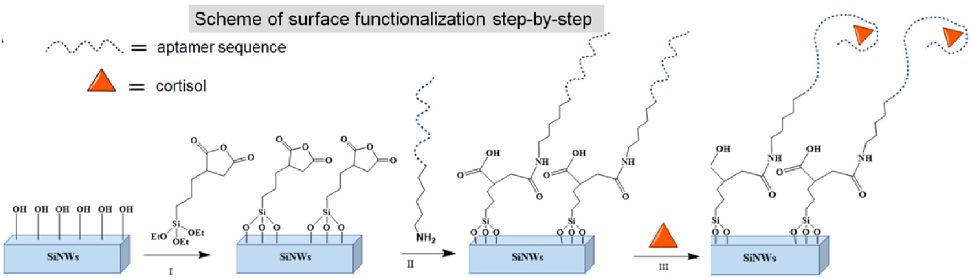
Figure 12. Schematic diagram of the surface functionalization of SiNW with the cortisol-specific aptamer (adapted with permission from [70] . Copyright 2020 American Chemical Society).